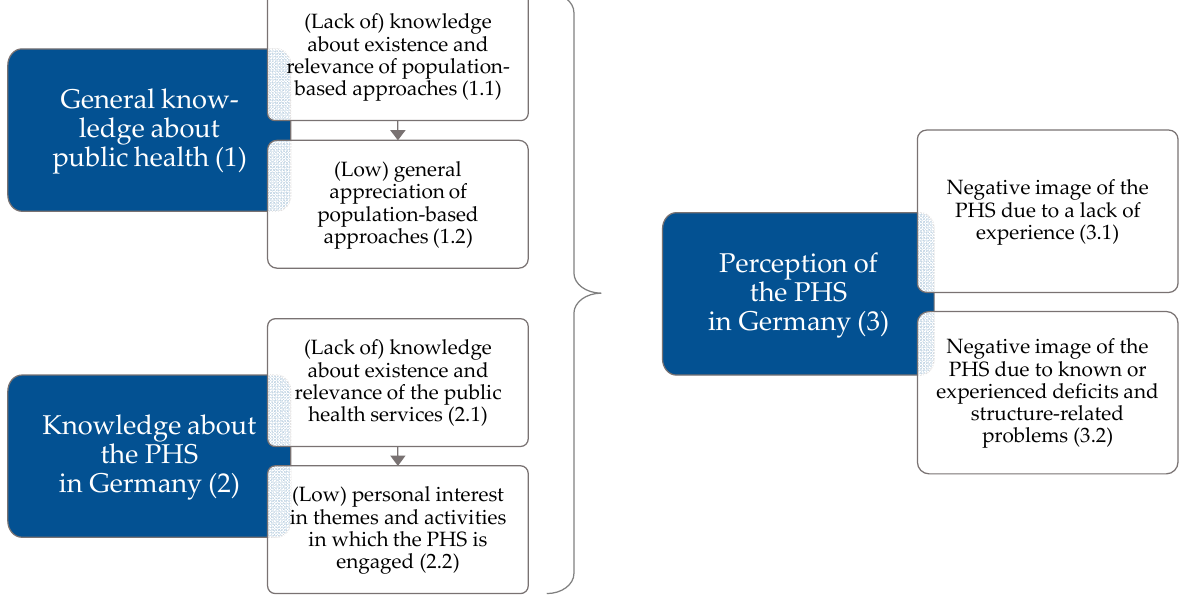
Figure 1. Logic model on potential causes and pathways of the perceived low attractiveness of the public health service (PHS) and an occupation within it.